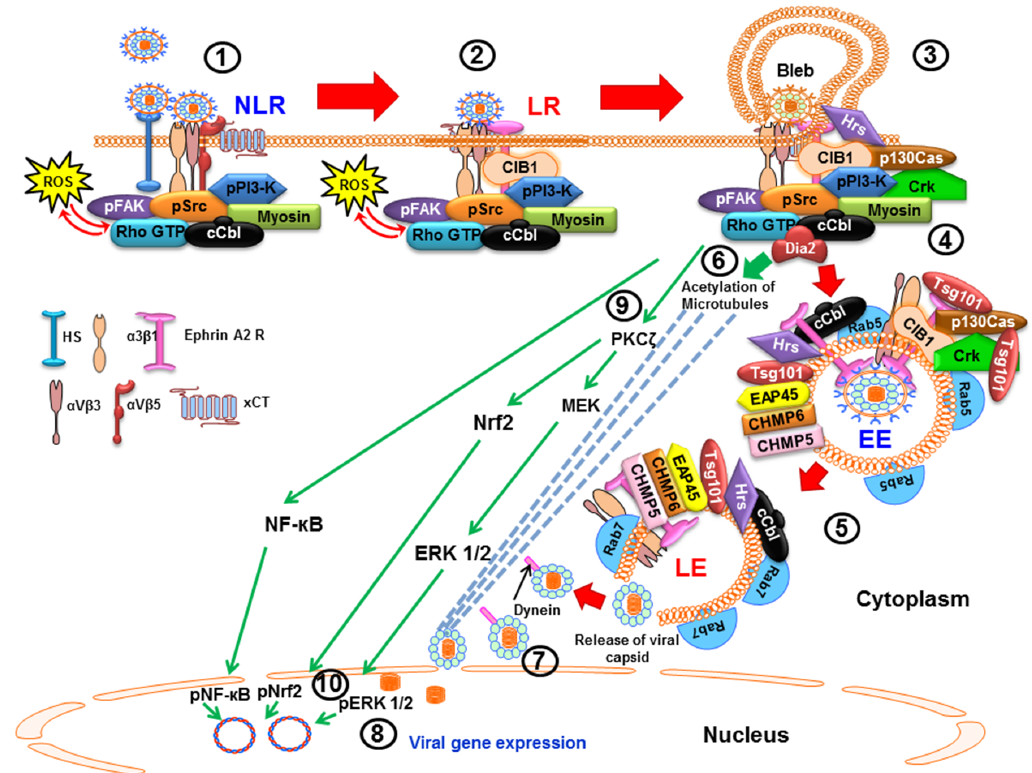
Figure 1. Schematic diagram depicting the entry of KSHV by macropinocytosis and subsequent trafficking in human microvascular dermal endothelial cells (HMVEC-d) and the various signal cascades induced by KSHV early during infection to aid in the various steps of infection. (1) The initial attachment of KSHV is with HS in the non-lipid raft (NLR) region of the membranes which concentrates the virus particles. This is immediately followed by the interactions with α 3 β 1, α V β 3 and α V β 5 integrins and xCT molecules. (2) Within 1–5 min of infection, this interaction induces the phosphorylation of FAK, Src, PI3-K as well as recruitment of the adaptor proteins c-Cbl and CIB1, c-Cbl mediated monoubiquitination of α 3 β 1 and α V β 3, and rapid translocation of KSHV into the lipid raft (LR) along with the α 3 β 1, α V β 3, and x-CT receptors but not α V β 5. KSHV interactions with the receptors also lead to the production of ROS, which in turn amplifies FAK, Src and the Rho-GTPase and ROCK1 and Rac1. (3) In the LR, KSHV interacts with EphA2R, which amplifies the signal cascades. (4) Infection induced ESCRT-0 protein Hrs associates with the membrane and ROCK1 and induces a local pH change. Activated c-Cbl interacts with myosin IIA and results in bleb formation, its retraction and macropinosome formation that enclose the viral particles with virus associated integrins and EphA2R in the luminal face of the vesicles and CIB1, Crk, and p130Cas in the cytoplasmic side. (5) Virus containing early and late endosomes is associated with Rab5 and Rab7, respectively, as well as with integrins, EphA2, CIB1, Crk, p130Cas and ESCRT-I-III proteins. The KSHV lipid envelope membrane fuses with the endosomal membrane mediated by the viral glycoproteins to release the capsid and the enclosed dsDNA viral genome into the cytoplasm. (6) RhoA-GTPase mediated Dia-2 dependent acetylation of microtubules helps in the rapid transport of capsid towards the nucleus and the capsid disassembles near the nuclear pore resulting in the delivery of viral DNA into the nucleus (7). (8) Viral gene expression is initiated by the infection induced host ERK1/2, NF- κ B and Nrf2 transcription factors that translocate to the nucleus from the cytoplasm (9 and 10). Studies summarized in this review demonstrate that: (i) KSHV infection induced FAK, Src, PI3-K, Rho-GTPase and ROS play roles in KSHV entry by endocytosis and actin remodeling; (ii) PI3-K, RhoA-GTPase and Dia 2 molecules play roles in microtubule acetylation, reorganization and transport of capsid to the nuclear vicinity; and (iii) ERK1/2, NF- κ B and Nrf2 play roles in viral and host gene expression and